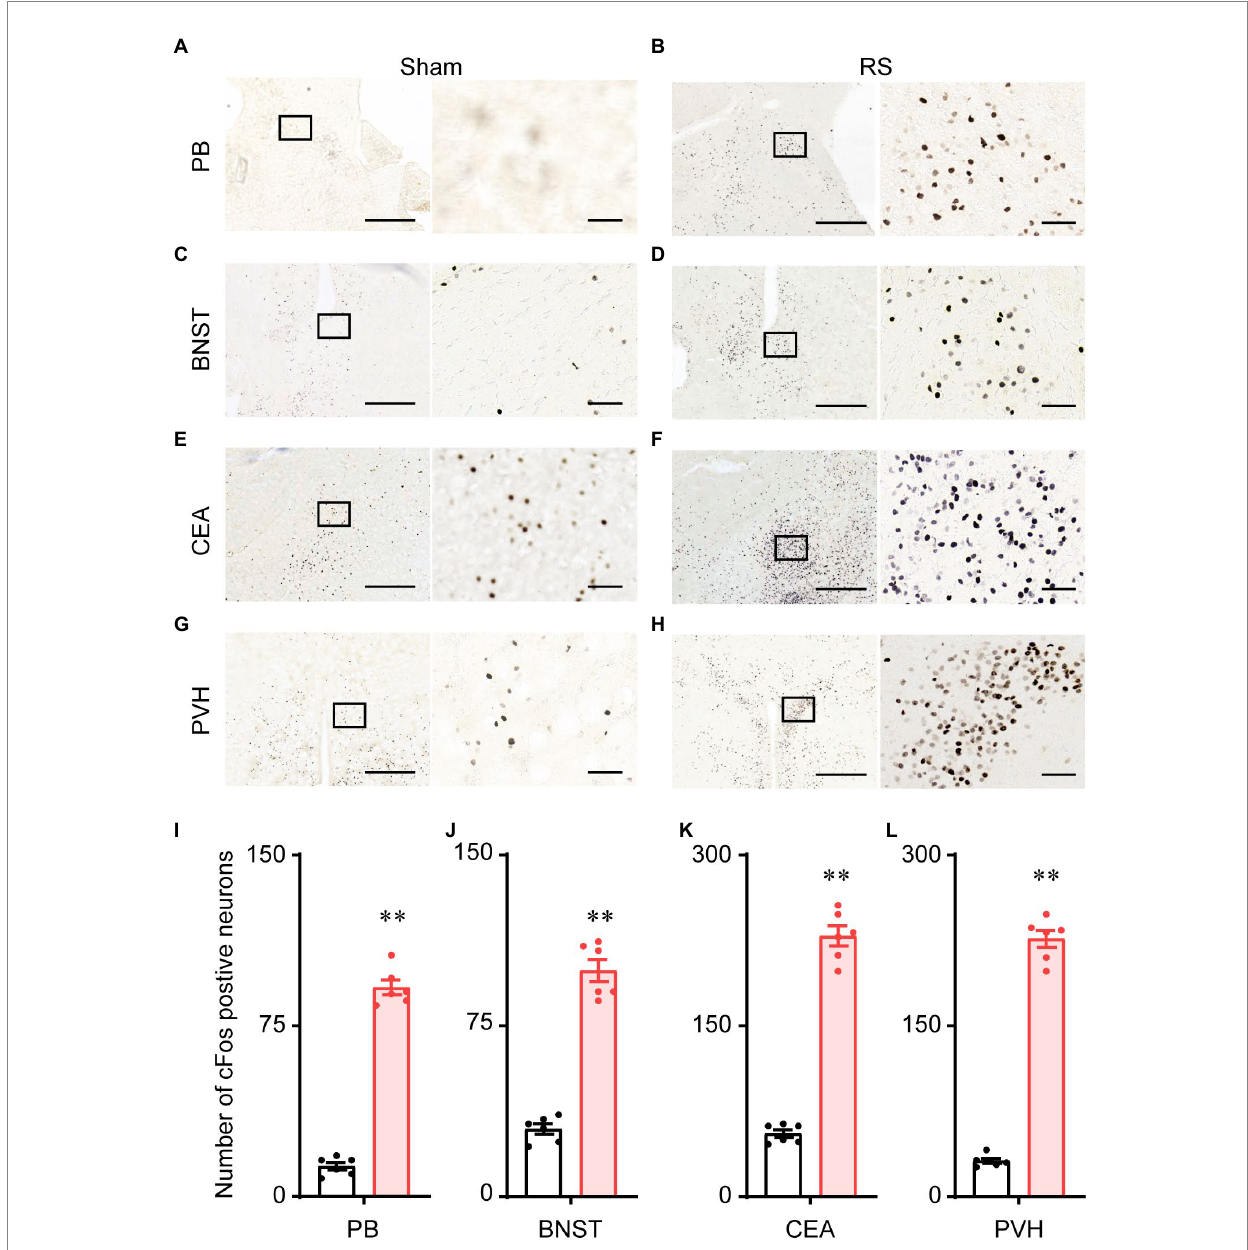
FIGURE 9 Expression of the c-Fos protein in the mouse brain. Representative images of c-Fos expression in the PB (A,B) , BNST (C,D) , CEA (E,F) , and PVH (G,H) after sham and RS manipulation in mice. (I–L) . Mean numbers of c-Fos-positive neurons in PB (I) , BNST (J) , CEA (K) , and PVH (L) . The right panel shows an enlargement of the box in the left panel. Scale bar: 500 μ m in the left panels and 50 μ m in the right panels. ** p < 0.01, compared with sham, n = 6. RS, restraint stress; PB, parabrachial nucleus; BNST, bed nucleus of the stria terminalis; CEA, central amygdala; PVH, paraventricular